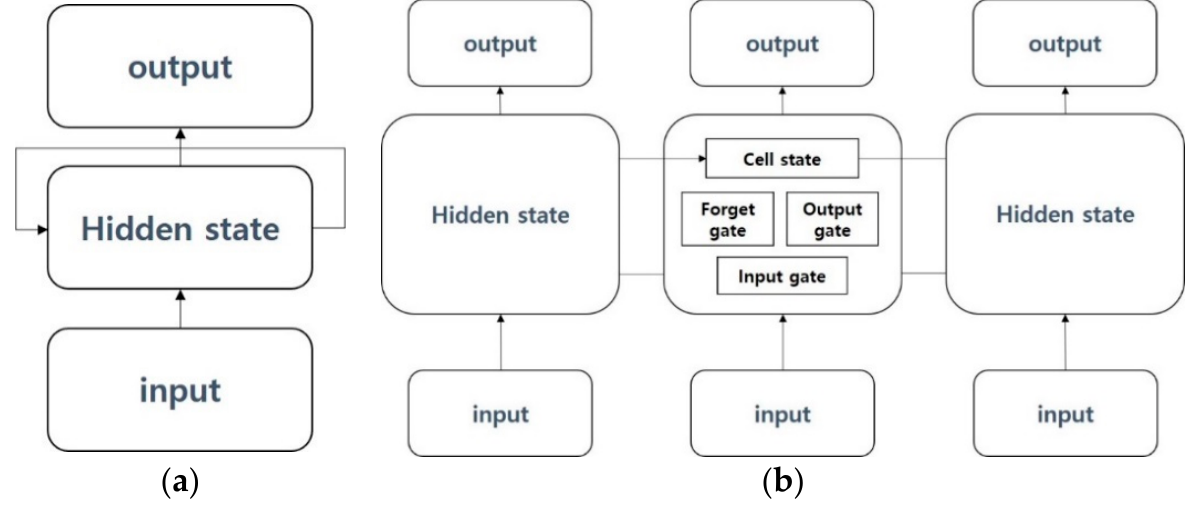
Figure 5. ( a ) Vanilla recurrent neural network (RNN) model; ( b ) long short-term memory (LSTM) model.